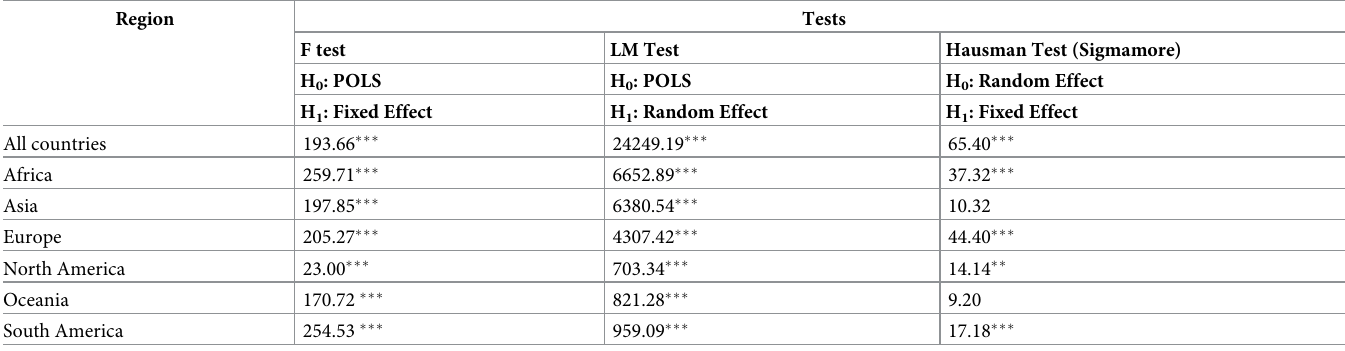
Table 3. Specification tests for panel data